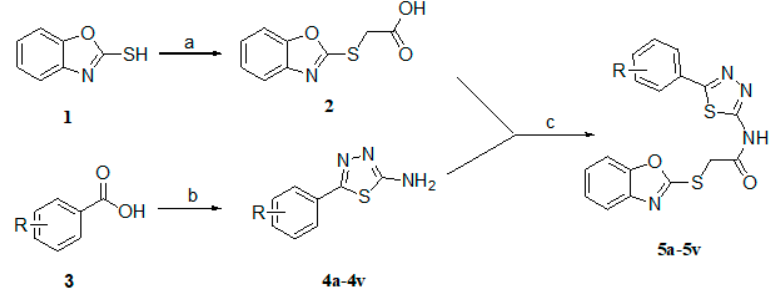
Figure 1. Preparation of benzo[d]oxazole-based derivatives.